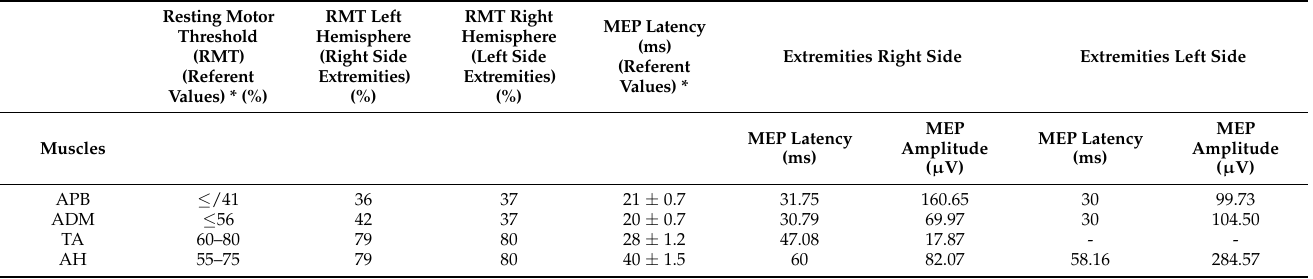
Table 2. Stimulation intensity, latency, and amplitude of MEP responses recorded from upper and lower limb muscles in No3.